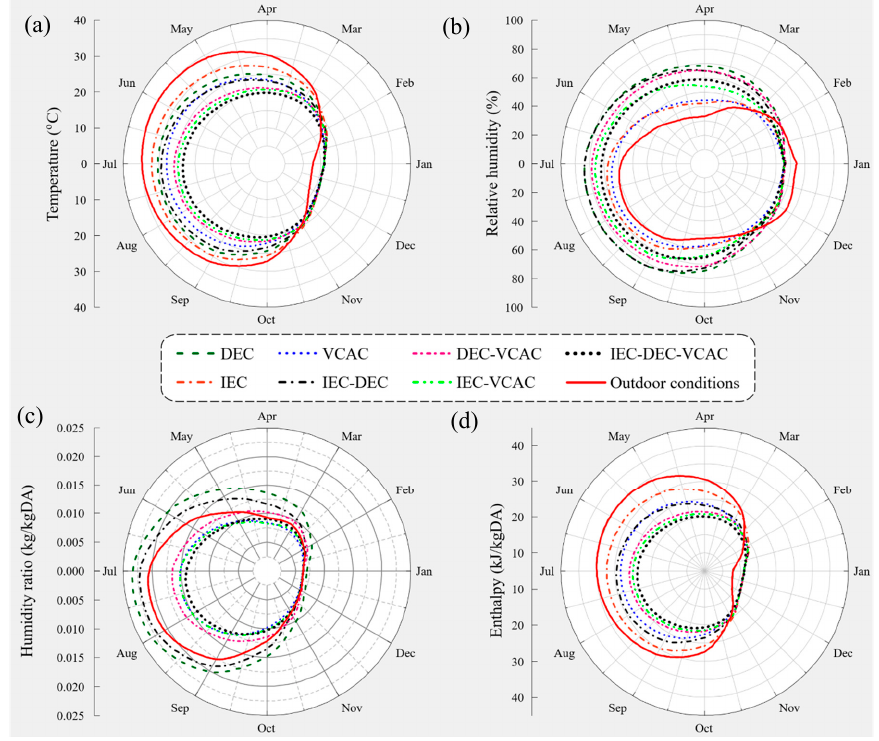
Figure 5. Performance evaluation on monthly basis for the proposed seven AC system configurations using annual climatic data.